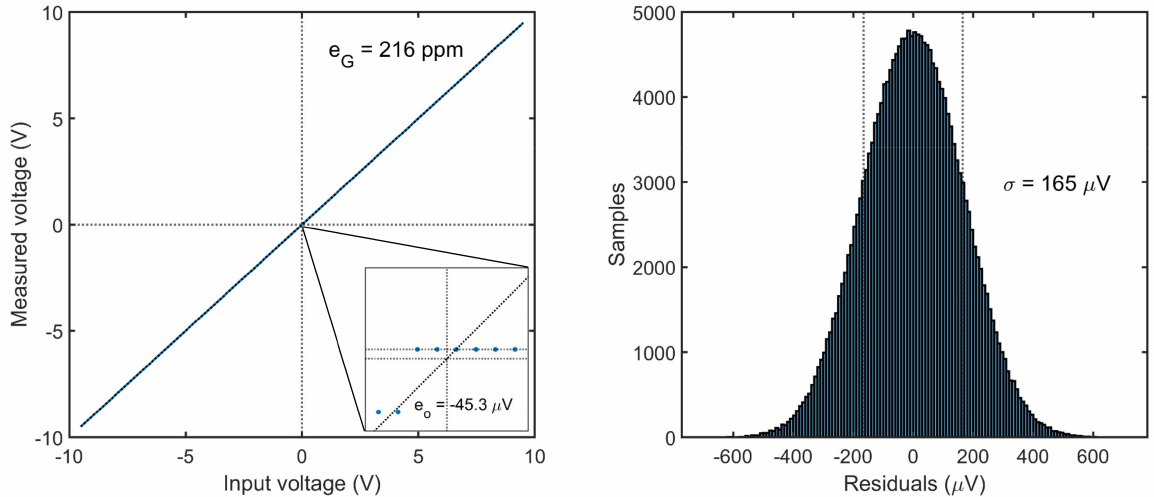
Figure 10. Systematic errors of the static characteristic ( left ) and linear regression residuals ( right